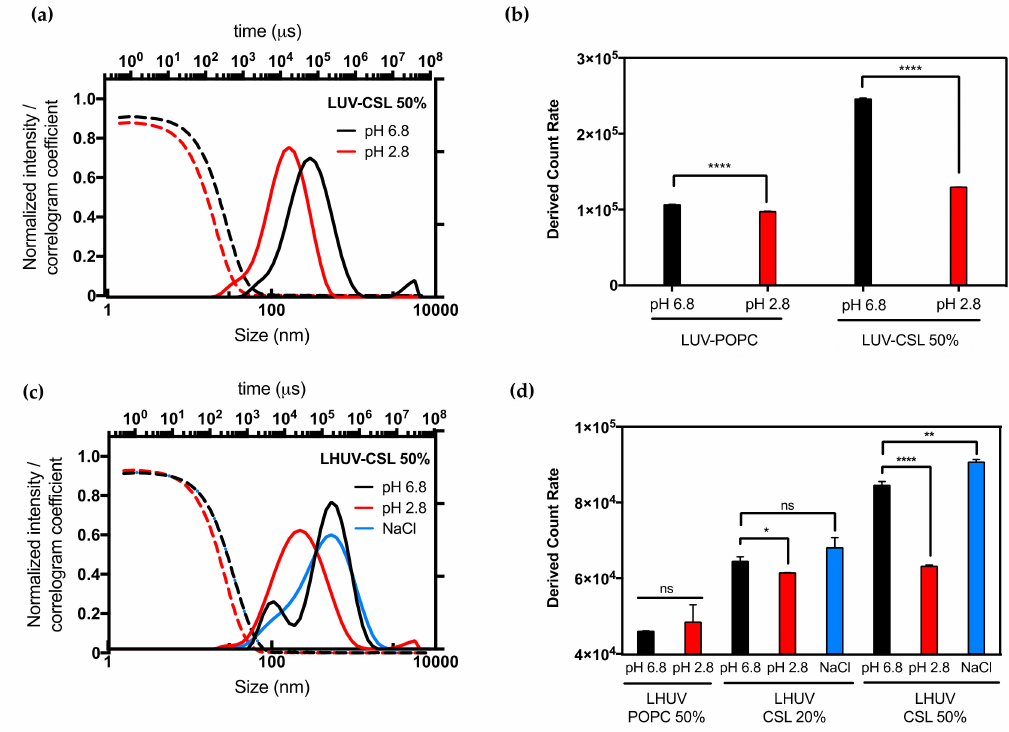
Figure 1. DLS and ζ -potential measurements of LUV and LHUV at pH 6.8 and 2.8. ( a) Size distribution and correlogram of LUV-CSL 50%; ( b) Derived count rate and ζ -potential of both LUV-POPC and LUV-CSL 50% at both pHs; ( c) Size distribution and correlogram of LHUV-CSL 50% at both pHs and after NaCl addition; ( d ) Derived count rate and zeta potential of LHUV-POPC 50%, LHUV-CSL 20% and 50% at both pHs and after NaCl addition. Data represent the mean ± SD ( n = 3). Student’s t -test, where * ( p < 0.05); ** ( p < 0.005), **** ( p < 0.0001) and ns (not statistically